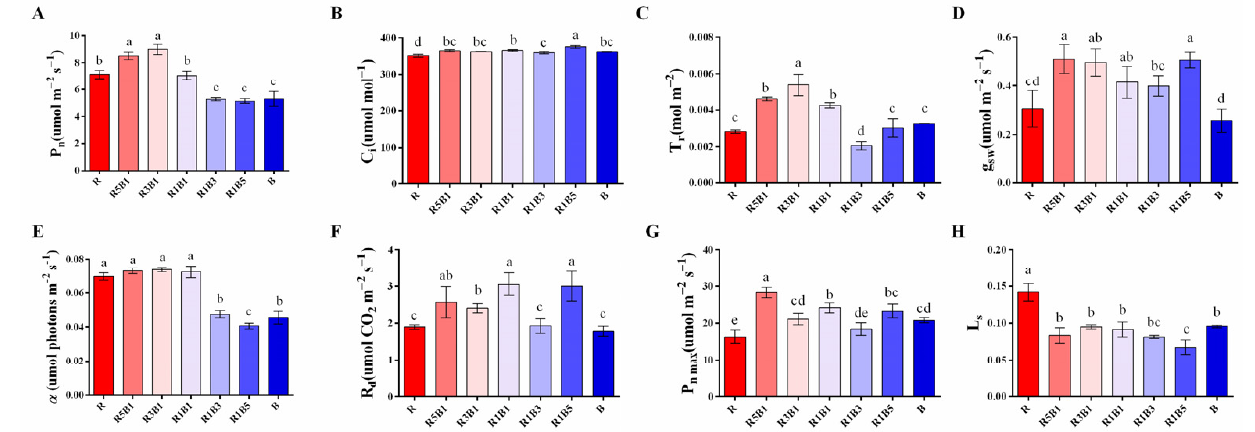
Figure 5. Effect of various R and B ratios on the P n : net photosynthetic rate ( A ), C i : intercellular carbon dioxide concentration ( B ), T r : rate of transpiration ( C ), g sw : stomatal conductance based on water ( D ), α : fraction of light absorbed by photosystem II ( E ), R d : dark respiration rate ( F ), P n max : maximum net photosynthetic rate ( G ), and L s : stomatal limitation ( H ) values of coriander. Bars represent the mean ± SD ( n = 6). According to one way ANOVA, different letters denote statistically significant differences between treatments (Duncan’s test, p < 0.05). R: monochromatic red light; R1B5: red to blue ratio = 1:5; R1B3: red to blue ratio = 1:3; R1B1: red to blue ratio = 1:1; R1B3: red to blue ratio = 1:3; R1B5: red to blue ratio = 1:5; B: monochromatic blue light. As shown in Figure 6, P n and g sw increased with increasing light intensity. Except for R1B3, the light response curve increases faster under red and blue mixed light treatment compared to the monochromatic R and B light treatment. The increase in the photosynthetic rate slowed when the light intensity exceeded 600 µ mol m − 2 s − 1 in the monochromatic R treatment. (Figure 6A). Compared with red and blue monochromatic light, red and blue mixed light showed higher g sw , and the increase in the g sw rate slowed when the light intensity exceeded 400 μ mol m − 2 s − 1 in the monochromatic R treatment (Figure 6B). Generally, photosynthesis was promoted in the mixed R and B light treatments when the R light percentage was high (monochromatic R, R5B1, and R3B1) treatments.